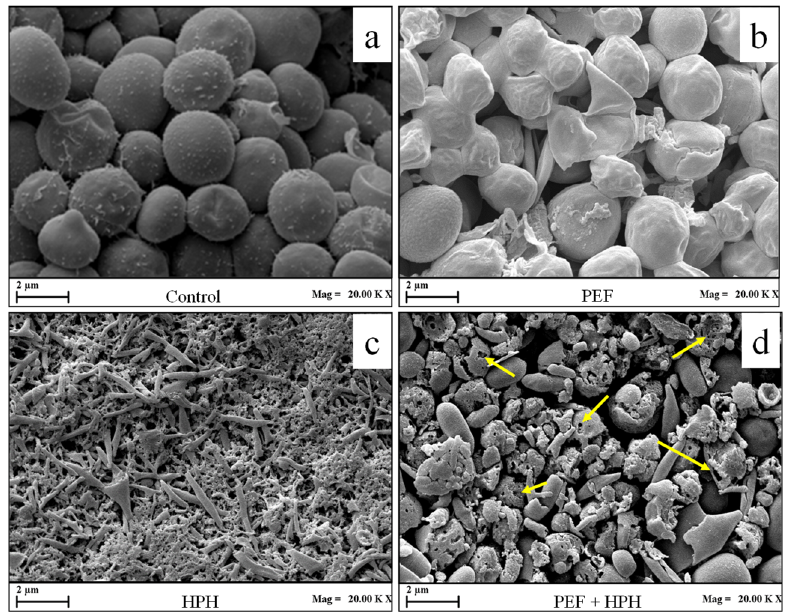
Figure 3. Scanning electron microscopy (SEM) of C. vulgaris cells, before ( a ) and after the application of PEF alone ( b ), HPH alone ( c ), and combined PEF + HPH ( d ).